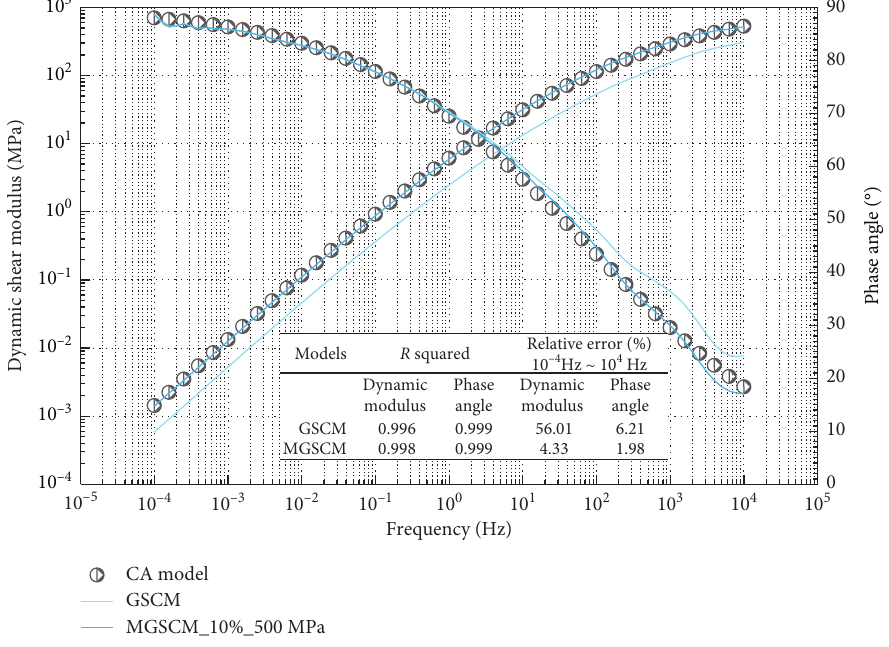
Figure 10: Predicted complex moduli for mastic (100%).